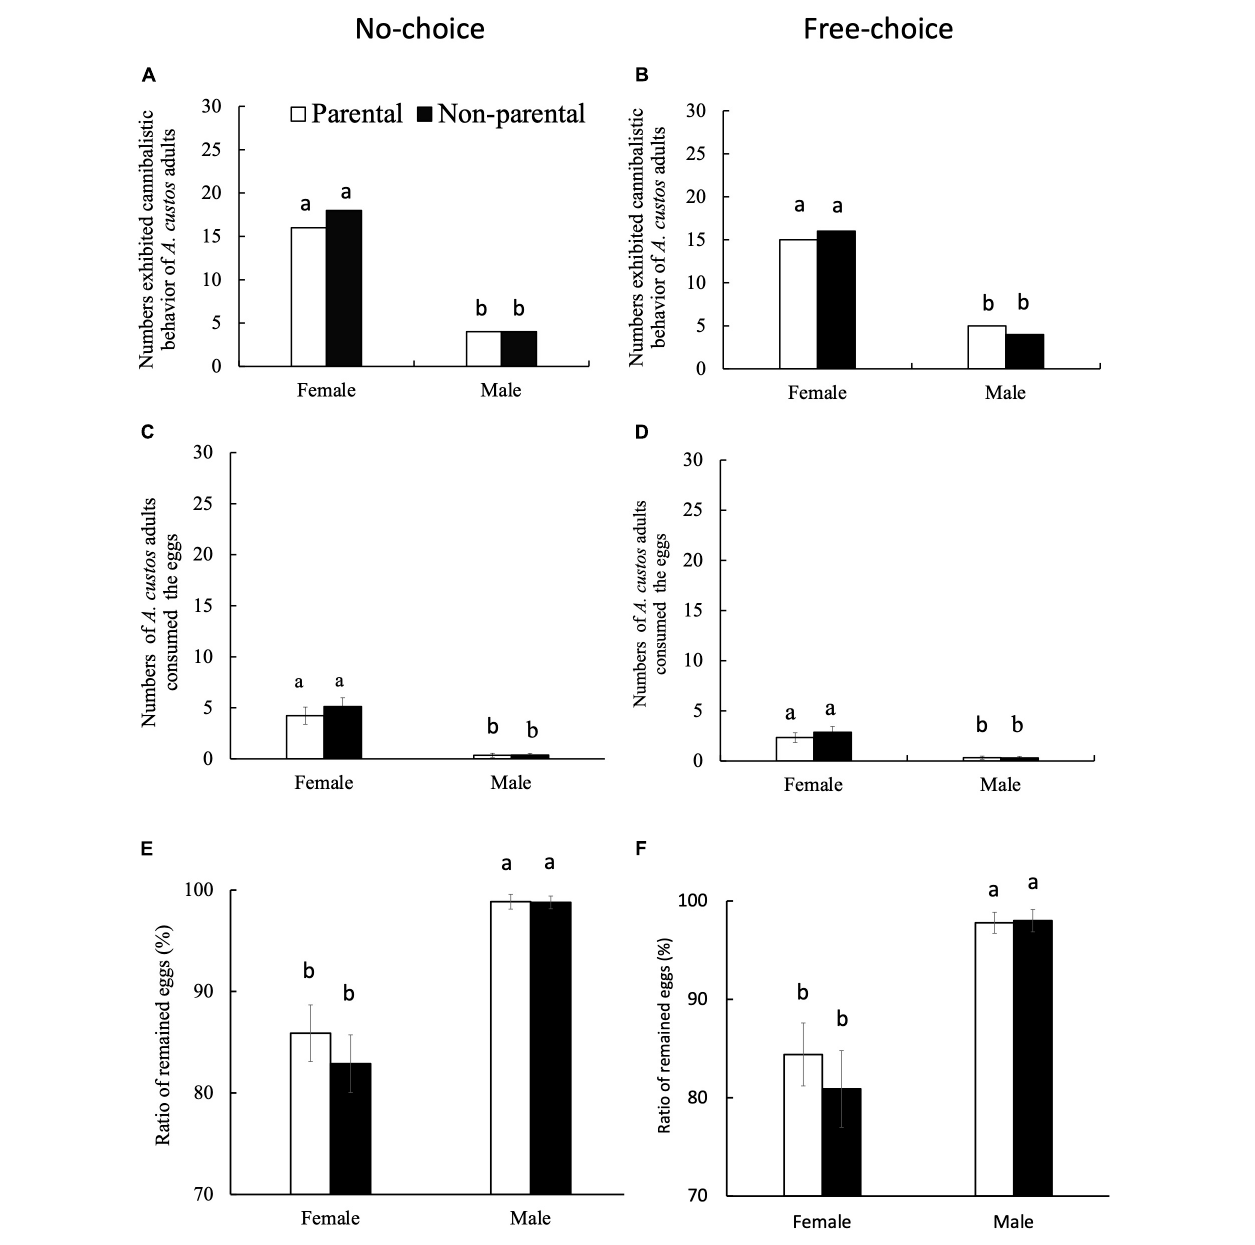
FIGURE 5 | Egg cannibalism exhibited by female and male A. custos adults incubated under no-choice and free-choice conditions for 7 days. Under the no-choice condition, each A. custos adult was either incubated with 30 parental or 30 non-parental eggs, whereas under the free-choice condition, each adult was simultaneously incubated with 15 parental and 15 non-parental eggs. Different lowercase letters on pillars indicate significant differences ( p < 0.05). A total of 30 replicates were used for each food-choice experiment. Numbers exhibited cannibalistic behavior of A. custos adults in No-choice (A) and Free-choice (B) conditions. Numbers of A. custos adults consumed the eggs in No-choice (C) and Free-choice (D) conditions. Ratio of remained eggs in No-choice (E) and Free-choice (F) conditions.